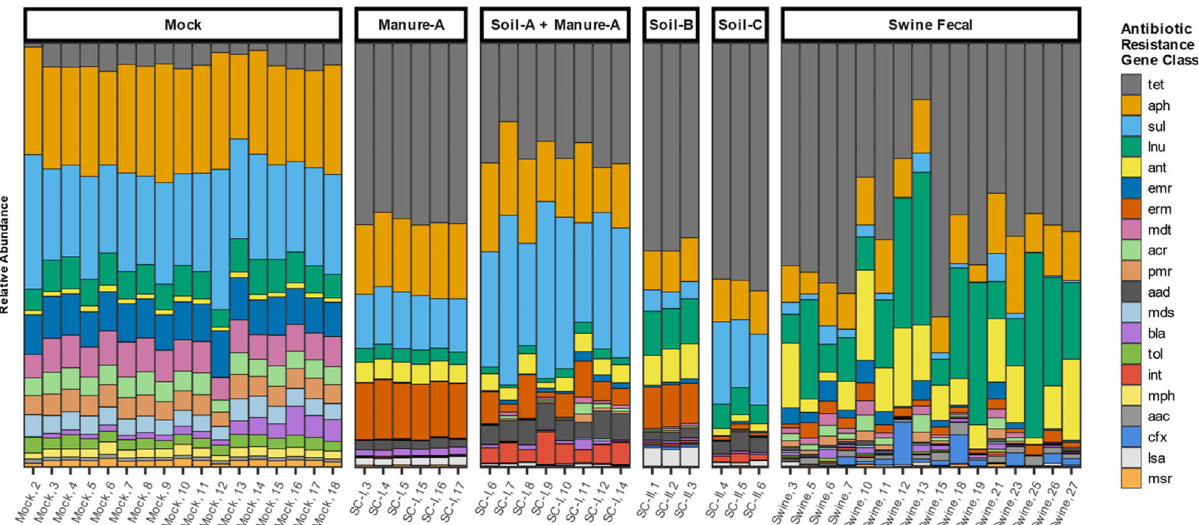
Fig. 3 ARG pro fi les by source matrix. Relative abundance of ARG classes identi fi ed for all mock community, swine fecal, soil, swine-manure, and manure- treated